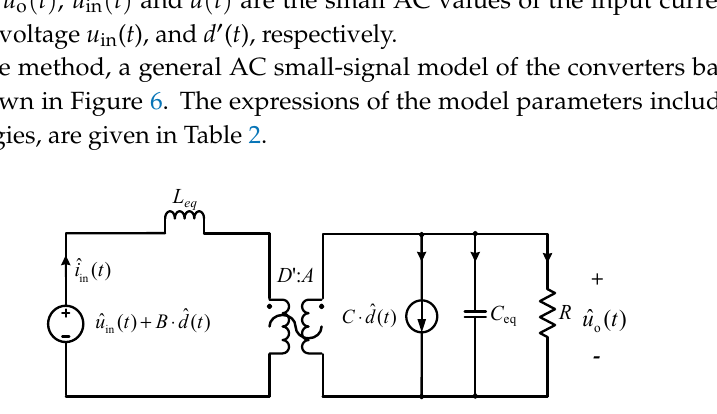
Figure 6. General small-signal AC model of the converters based on VM. Table 2. Key Parameters of the small-signal AC models for different converter circuits based on VM. Reference